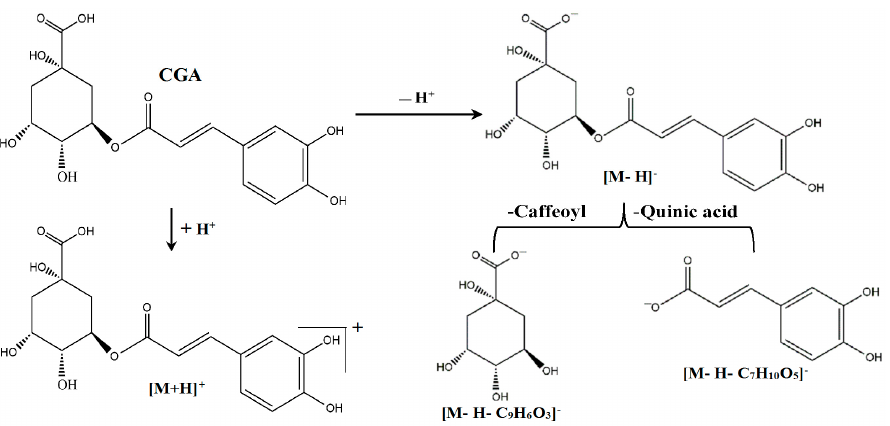
Figure 7. Marker constituents in the CSF of the rats treated with EUWE (4.0 g/kg) identified by ESI-MS/MS spectra in the negative ion mode.